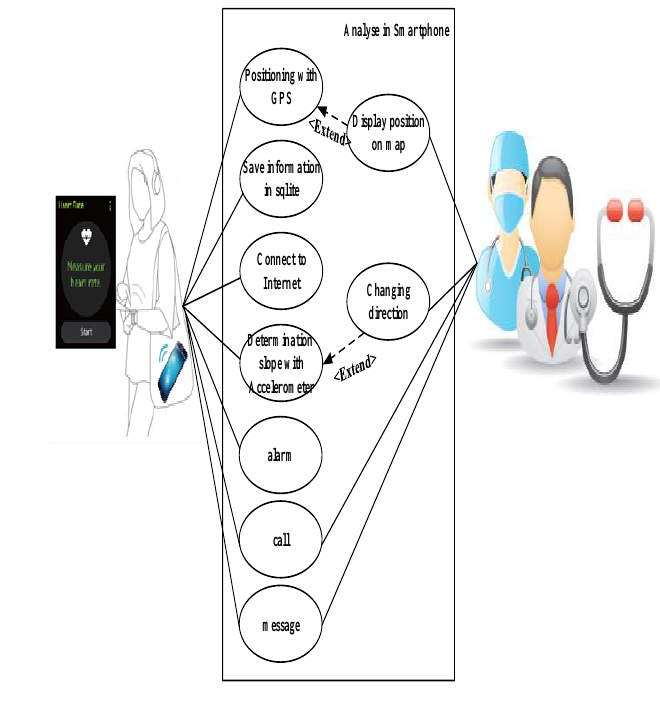
Figure 3. use case diagram